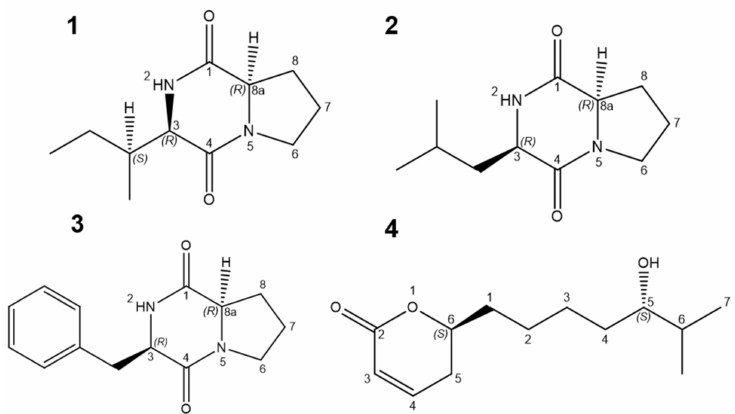
Figure 2. Schematic diagram of the molecular structure of the four monomer compounds. Compounds 1 – 4 .